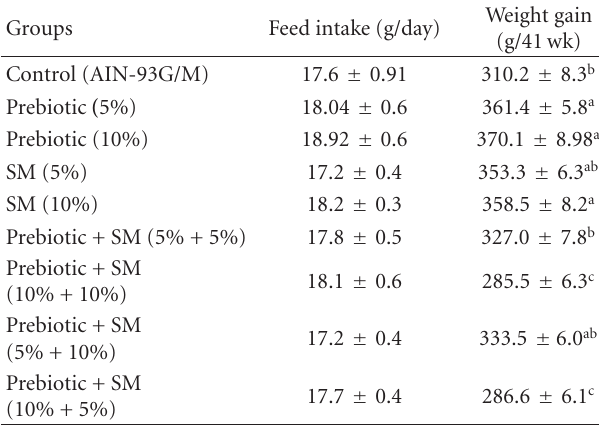
Table 2: Feed intake and weight gain in rats fed prebiotic and soybean meal.